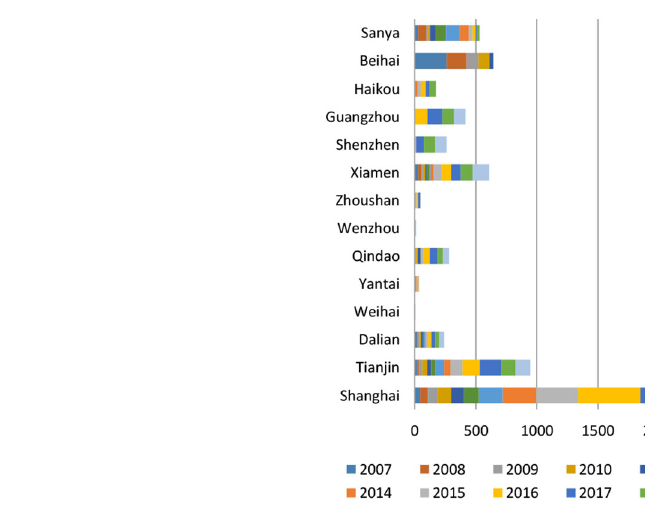
FIGURE 3 Cruise voyages of Chinese ports from 2007 to